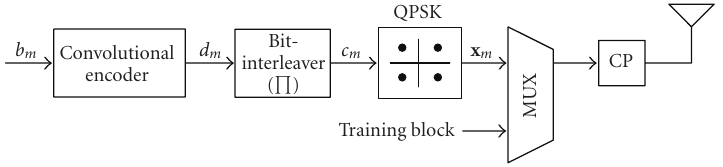
Figure 1: Block diagram of SC-FDE